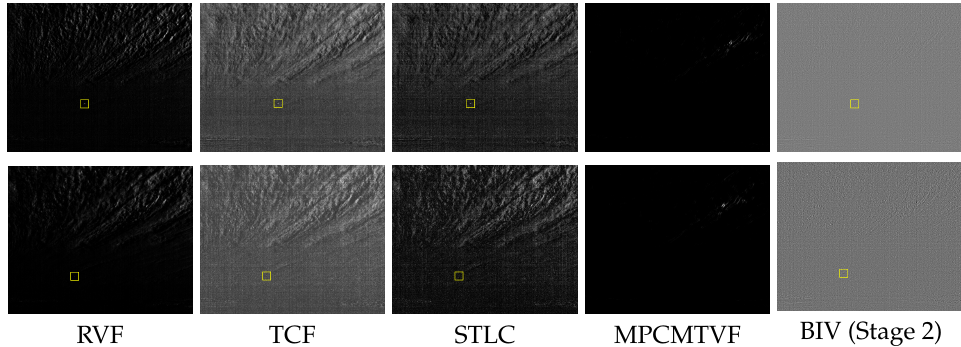
Figure 5. Temporal filtering results of the spatiotemporal methods for the images in Figure 3a (top row) and Figure 3b (bottom row). Conventional approaches failed to cope with the slow cloud motion. The MPCMTVF could not detect the target in both examples. In comparison, the first two stages of the BIV target detector (LMC output) maximized both the SNR and SCR of the target significantly better than the other methods. CSTDI is not shown separately as it uses the LMC output in its temporal filtering